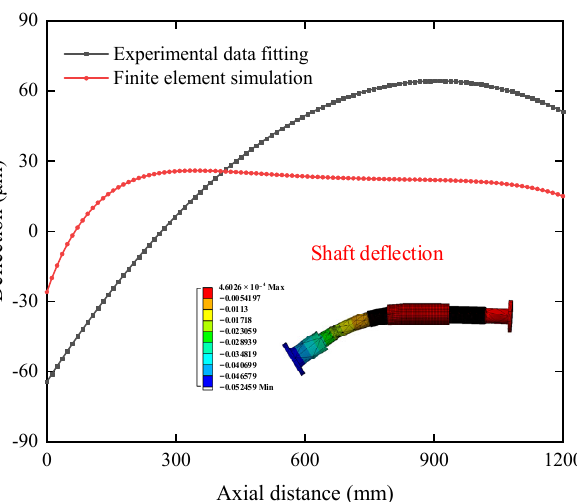
Figure 13. Three ‐ dimensional film ‐ thickness distribution at different speeds: ( a ) 35 rpm; ( b ) 65 rpm; Figure 13. Three-dimensional film-thickness distribution at different speeds: ( a ) 35 rpm; ( b ) 65 rpm; ( c ) 95 rpm; and ( d ) 135 rpm. ( c ) 95 rpm; and ( d ) 135 rpm.